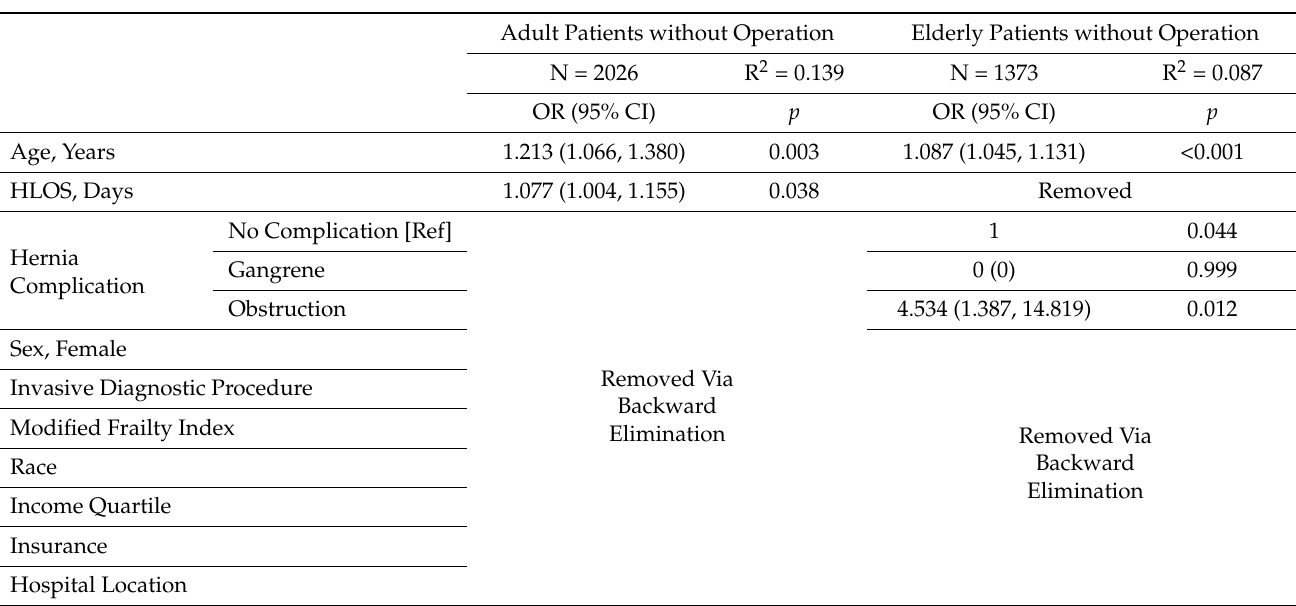
Table 6. Backward logistic regression analysis to evaluate the associations between mortality and different factors in emergently admitted patients with the primary diagnosis of umbilical hernia and not undergoing an operation. Mortality was the dependent variable. NIS